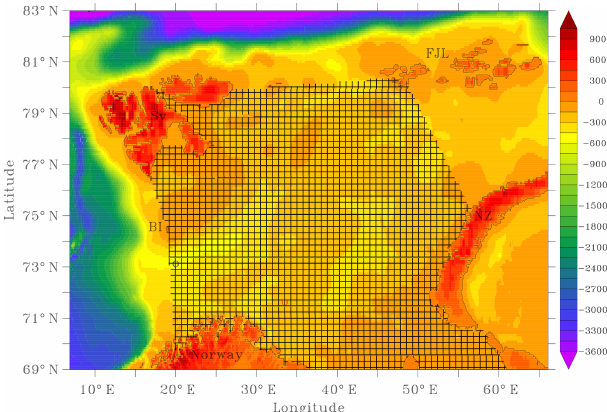
Figure 1. Bathymetry of the Barents Sea and its neighboring seas. Our analyses on the Barents Sea correspond to the shaded region. The Barents Sea Opening, located between the Norwegian coast and Bear Island, and the Kola sections are shown as blue and red circles, respectively. BI stands for Bear Island, Sv for Svalbard, FJL for Franz Josef Land and NZ for Novaya